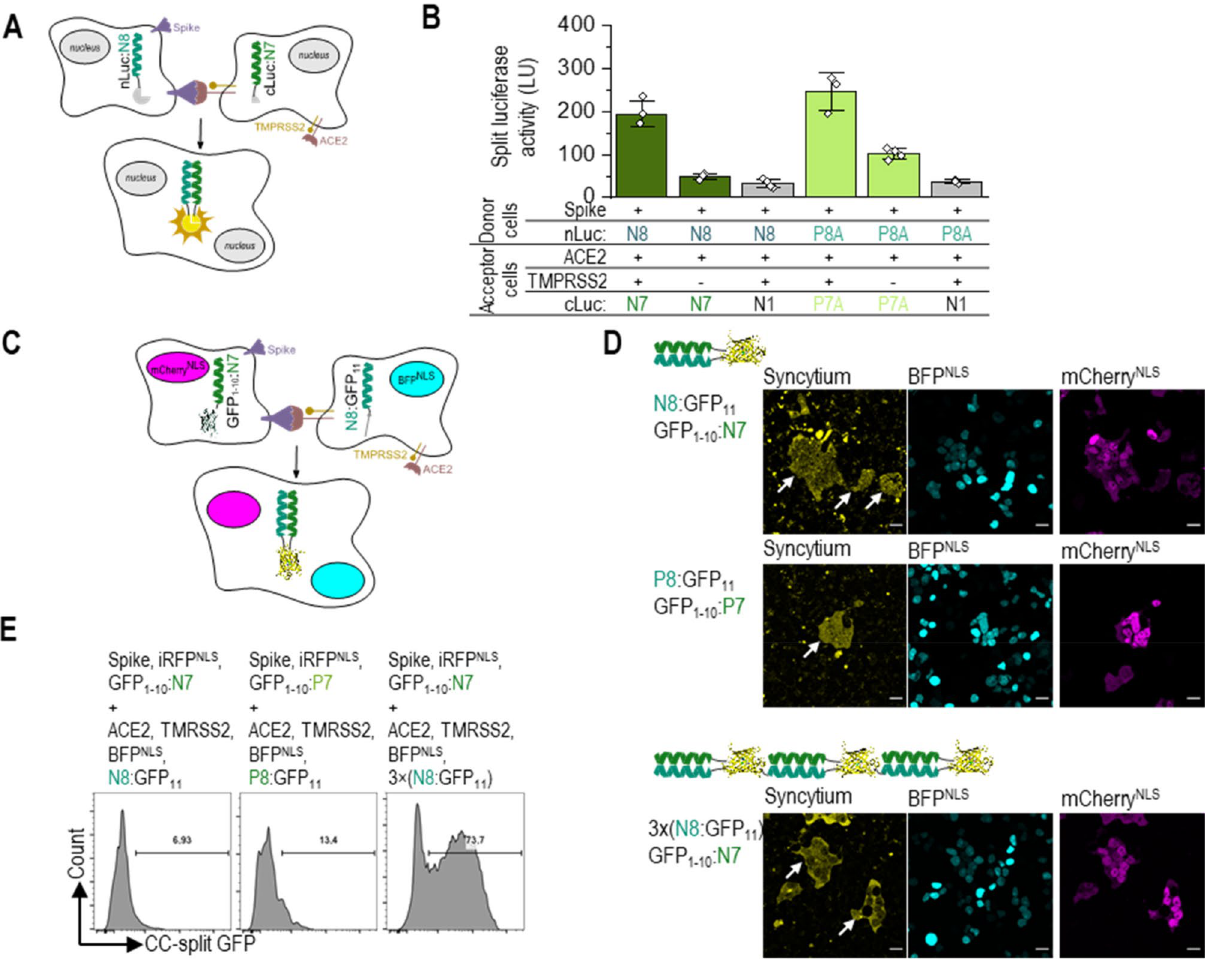
Figure 5. SARS-CoV-2 viral Spike protein-mediated syncytium formation assay based on designed CC split enzymes ( A ) Schematic representation of S protein-mediated cell–cell fusion assay. The donor cell is identified as the cell co-expressing CoV-2 Spike protein and nLuc:N8, the acceptor cells with co-expression of ACE2 receptor, TMPRSS2, and cLuc:N7. Syncytium formation is detected with reconstituted CC-split luciferase activity. ( B ) Luciferase activity as an indicator of cell fusion. 24 h after transfection, donor HEK293T cells transfected with plasmids expressing nLuc:N8 or nLuc:P8A (1000 ng), CoV-2 Spike-protein (10 ng), and acceptor cells expressing cLuc:N7 or cLuc:P7A or cLuc:N1 as control (1000 ng), ACE2 (20 ng), with or without TMPRSS2 (30 ng) were mixed in 1:1 ratio. Luciferase activity was measured 3 h later. The values represent the means (± s.d.) from four independent cell cultures, individually transfected with the same mixture of plasmids, and are representative of two independent experiments. ( C ) Schematic representation of syncytium formation between the donor cells expressing CoV-2 Spike protein, CC-split GFP and mCherry NLS , and the acceptor cells expressing ACE2 receptor, TMPRSS2, CC-split GFP, and BFP NLS . The fused cells are identified with BFP and mCherry nuclei and reconstituted CC-split GFP. ( D ) Confocal microscopy images of a mixture of donor HEK293T cells expressing the CoV-2 Spike protein (25 ng), mCherry NLS (500 ng), and GFP 1-10 :N7 or GFP 1-10 :P7 (100 ng) and the acceptor cells expressing ACE2 receptor (40 ng), TMPRSS2 (40 ng), BFP NLS (120 ng), and N8:GFP 11 , P8:GFP 11 or 3 × (N8:GFP 11 ) (100 ng). After 3 h mixing of donor and acceptors cells, syncytia (indicated with an arrow) were observed by a reconstituted GFP (yellow) and co-localization of BFP (cyan) and mCherry (magenta). ( E ) Flow cytometry analysis of a mixture of donor cells expressing the CoV-2 Spike protein (50 ng), iRFP NLS (50 ng), and GFP 1-10 :N7 or GFP 1-10 :P7 (500 ng) and the acceptor cells expressing ACE2 receptor (250 ng), TMPRSS2 (50 ng), BFP NLS (50 ng), and N8:GFP 11 , P8:GFP 11 or 3 × (N8:GFP 11 ) (650 ng). Percent of reconstituted split GFP for double iRFP and BFP positive cells 3 h after mixing donor and acceptor cells. For gating strategy, see Fig S8B. Representative results of two independent experiments are shown. For amounts of plasmids, see Table S2. Statistical analyses and the corresponding p-values are listed in Table